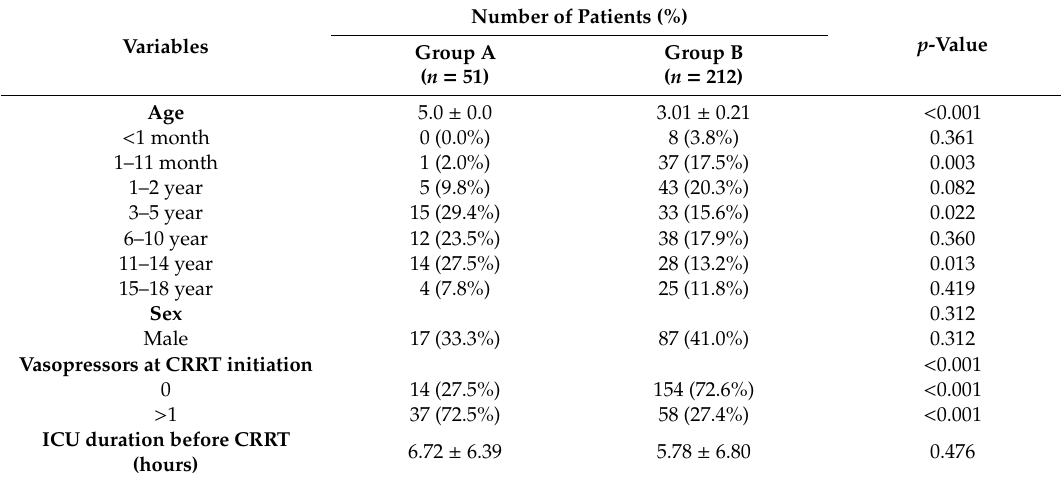
Table 1. Characteristics of patients receiving continuous renal replacement therapy (CRRT).